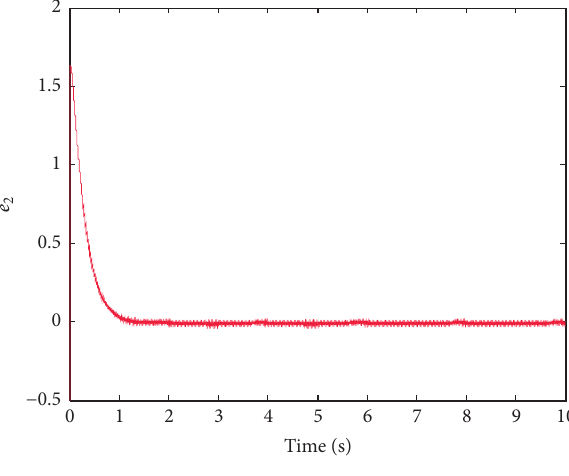
Figure 2: Tracking error 𝑒 1 of input signal 1.